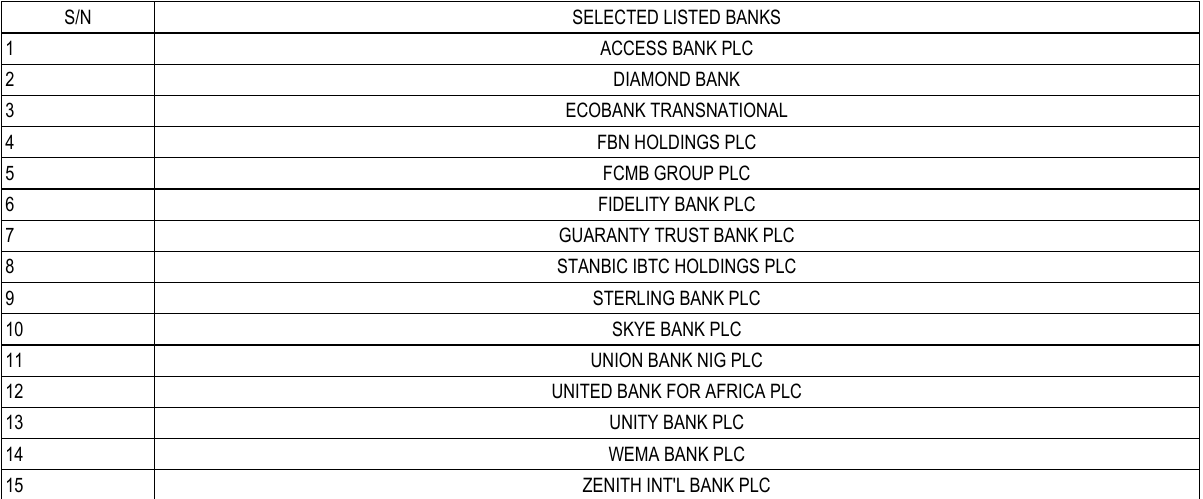
Table 1. List of banks